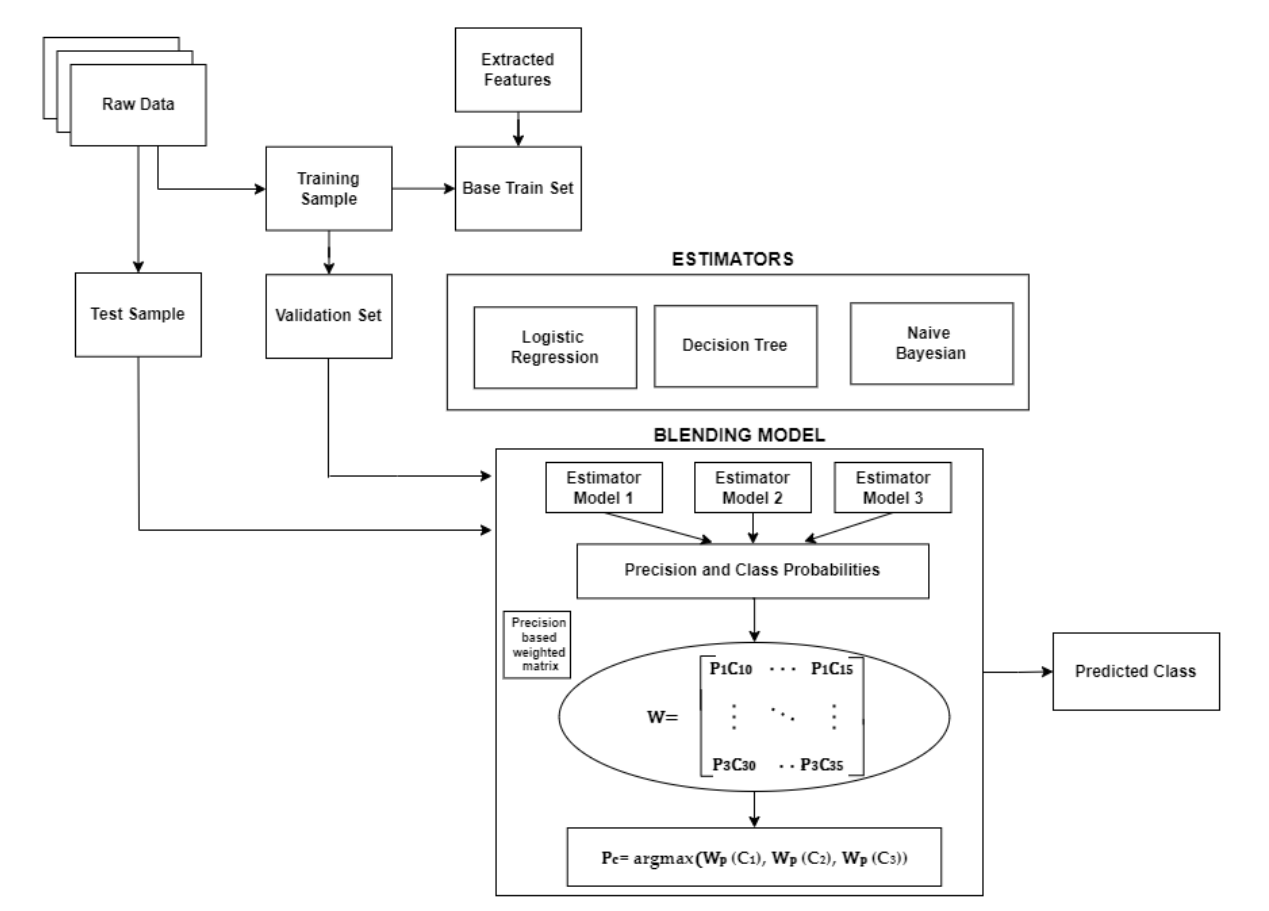
Figure 2. Precision-based blending ensemble model.